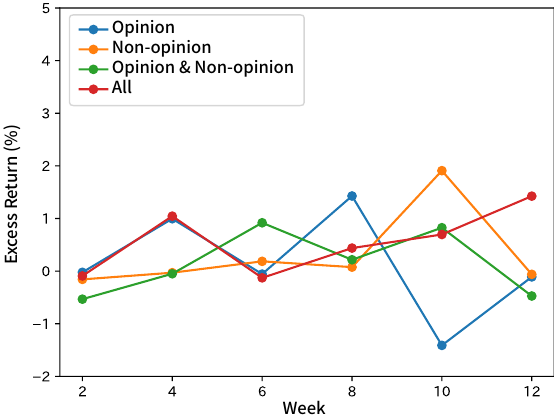
Figure 13. Excess returns of Broker E in forecasting excess